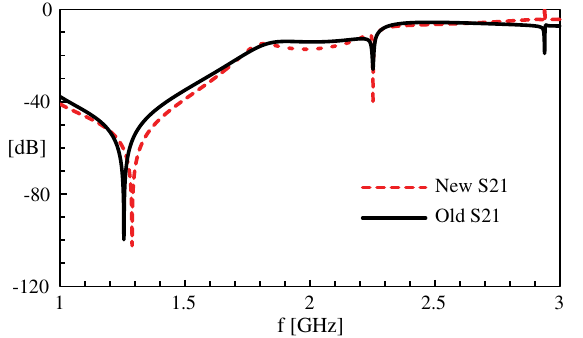
FIG. 7. Transfer functions of the new (red) and the current (black) HOM coupler. Note that the notches for the accelerating mode are not finally tuned to 1.3 GHz.